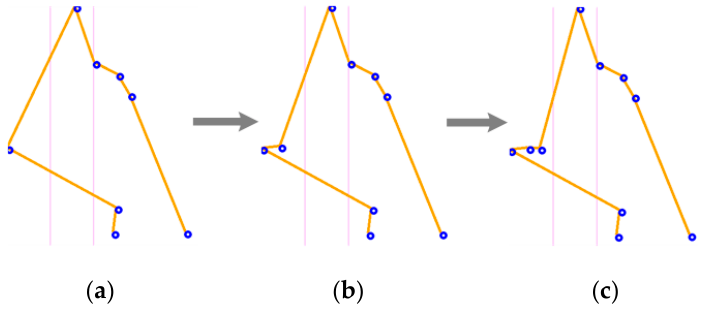
Figure 13. Feature restoration, ( a ) characteristic array of size 8; ( b ) characteristic array of size 9; ( c ) final characteristic array of size